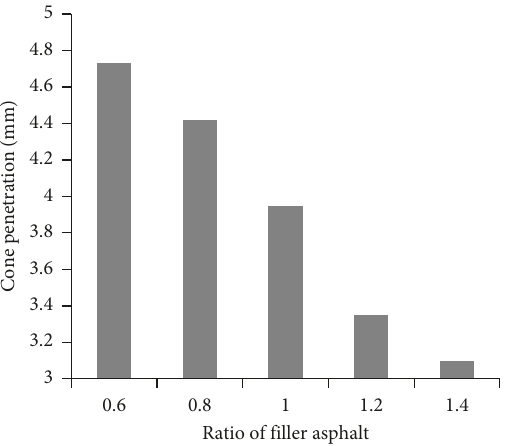
Figure 4: Influence of the ratio of filler asphalt on the cone penetration.